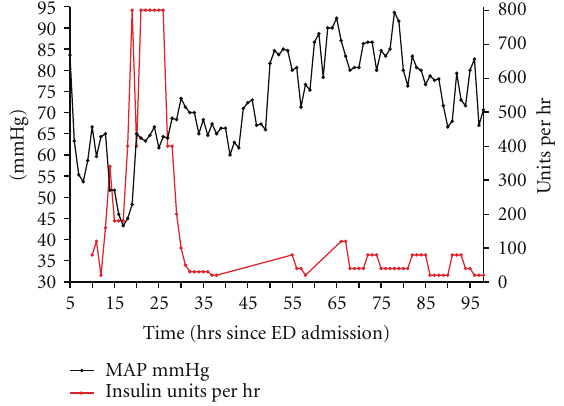
Figure 4: The e ff ect of hyperinsulinaemia-euglycaemia on MAP.